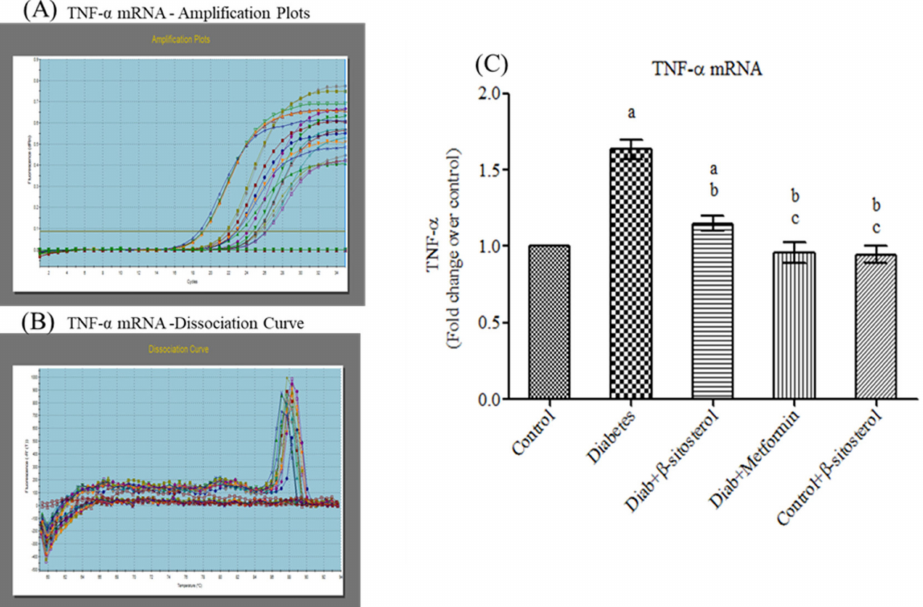
Figure 3. Effect of SIT on mRNA expression of TNF- α in adipose tissue of type-2 diabetic rats. The mRNA expression of TNF- α was assessed by real time-PCR. ( A ): Amplification plots; ( B ): dissociation curve analysis confirms the single product of TNF- α mRNA and ( C ): mRNA expression is given in fold change. Each bar represents mean ± SEM ( n = 6). Significance at p < 0.05. a Significantly different from the control group; b significantly different from the diabetic group and c significantly different from the β -sitosterol treated diabetic group.